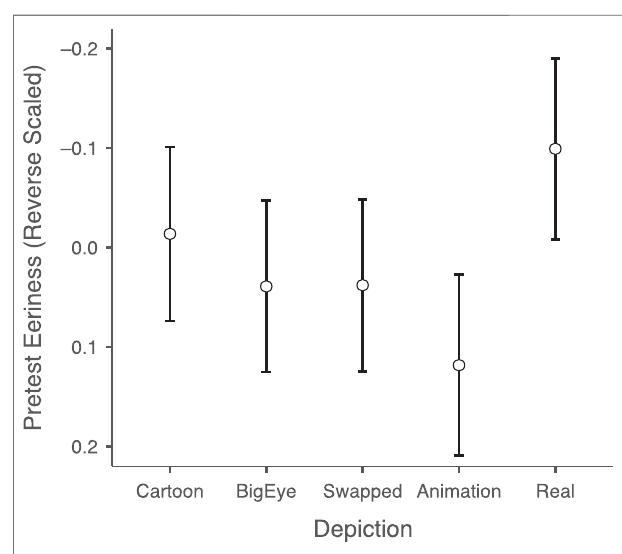
FIGURE 3 | Mean and 95% confidence interval of pretest Eeriness (reverse scaled) by